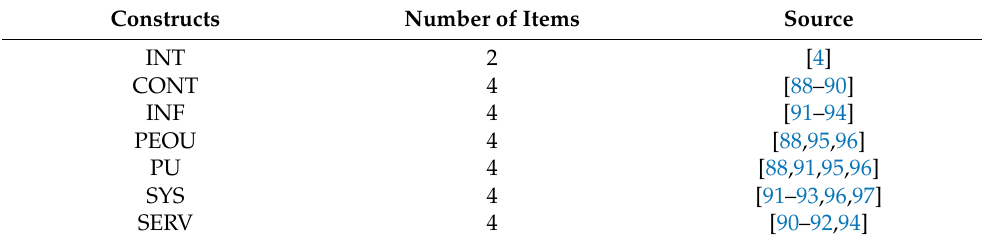
Table 1. Constructs and their sources.